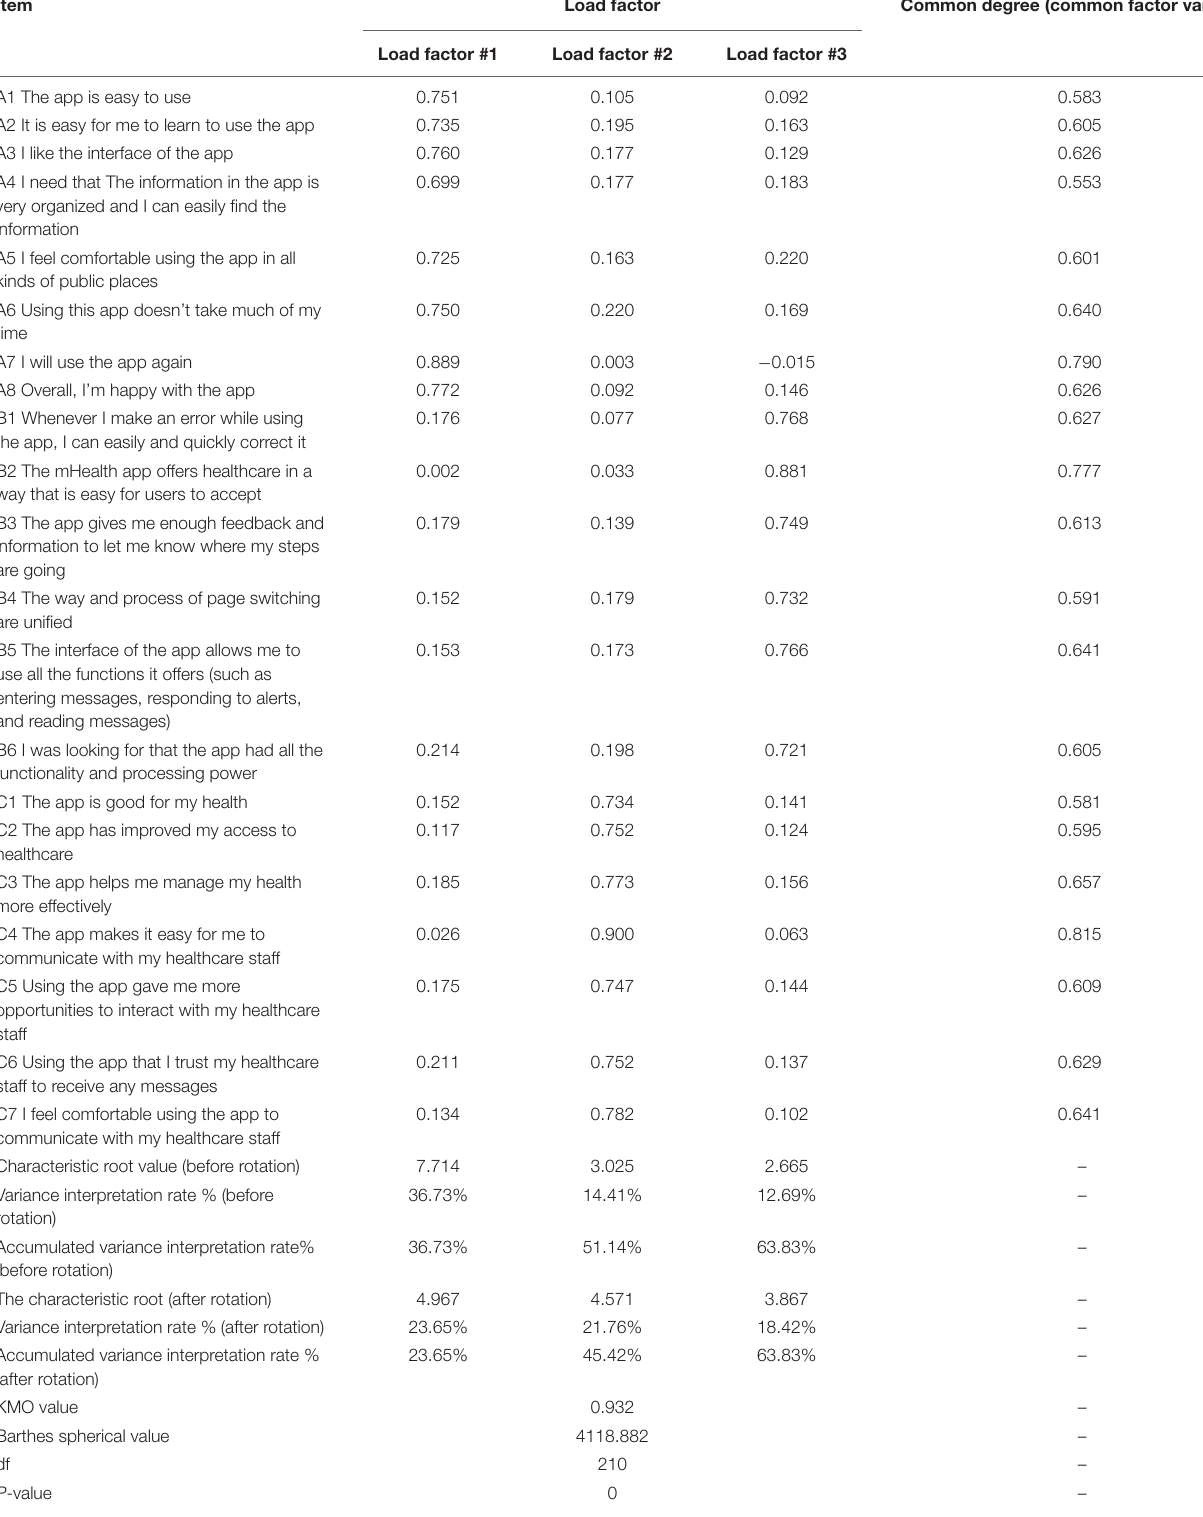
TABLE 6 | The results of